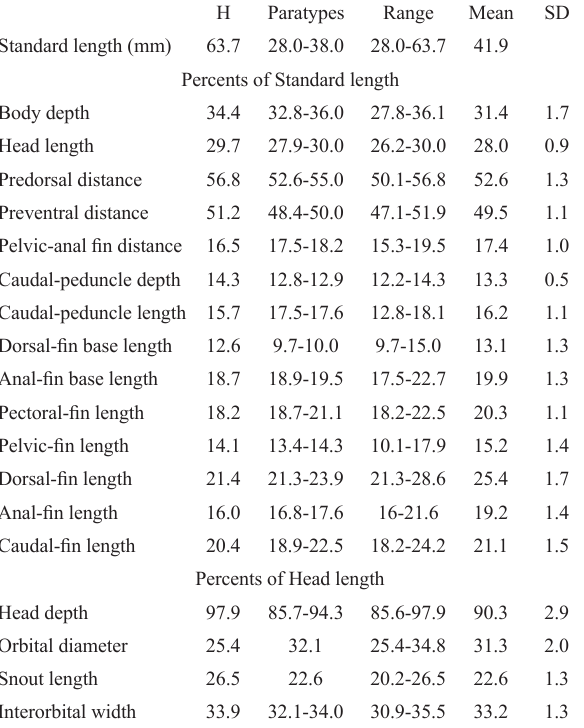
Table 2. Morphometric data of holotype (H) (MZUSP 52732), paratypes (MHNG 2594.044) and non-type specimens (DZSJRP 11039 and DZSJRP 14185) of Hasemania crenuchoides . SD = standard deviation, N = 38 including the holotype and paratypes.